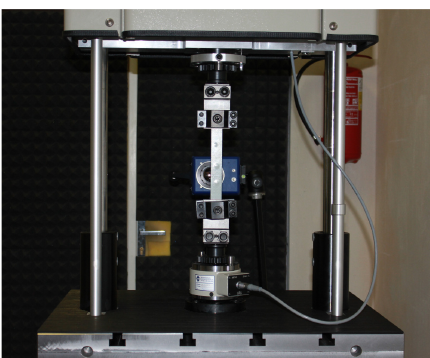
Figure 3. Experimental setup for thermographical observation of dynamic loading.